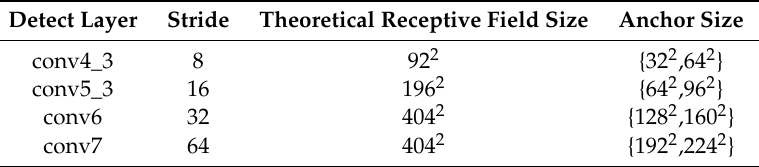
Table 1. The distribution of the anchors.